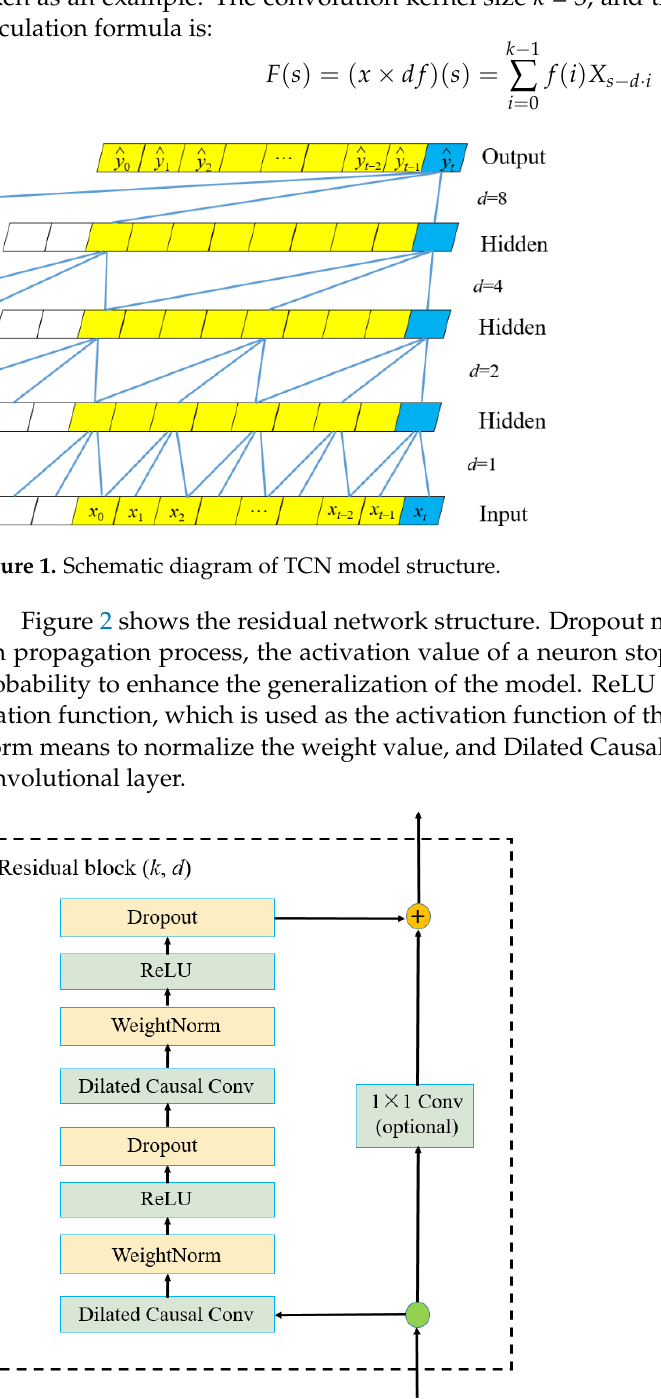
Figure 2. Residual network